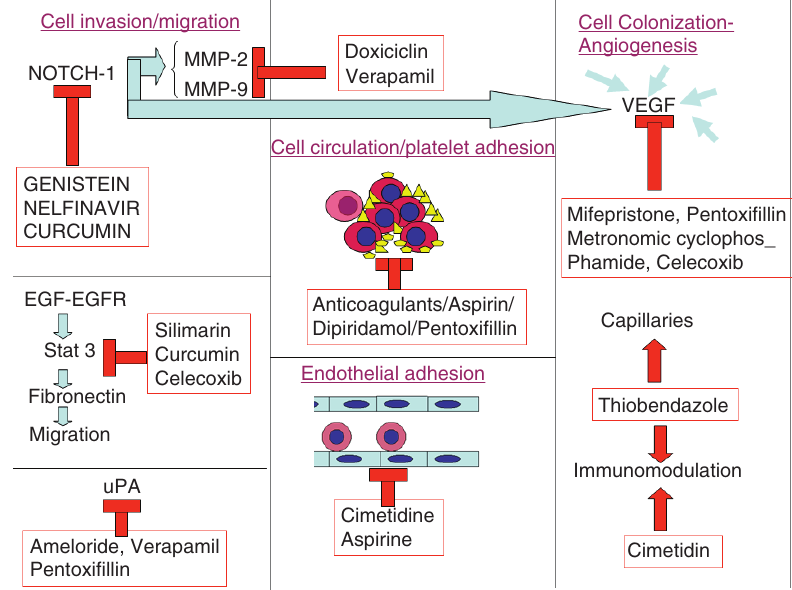
Figure 1. Repurposed drugs acting at different levels of the metastatic cascade. (uPA: urinary plasminogen